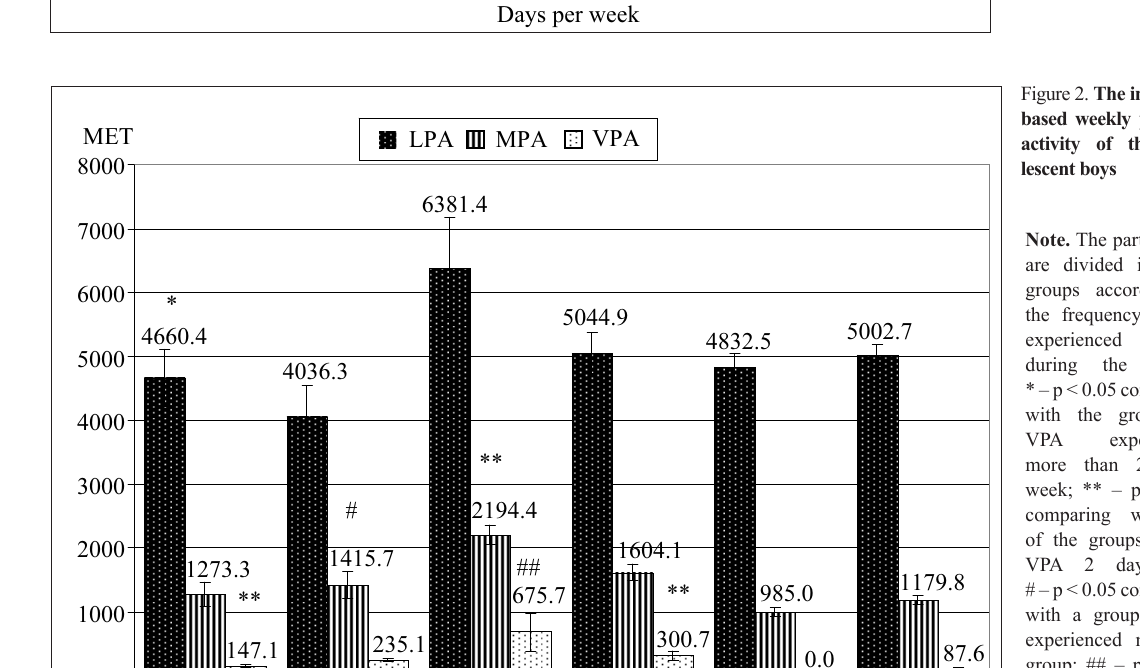
Figure 2. The intensity- based weekly physical activity of the ado- lescent